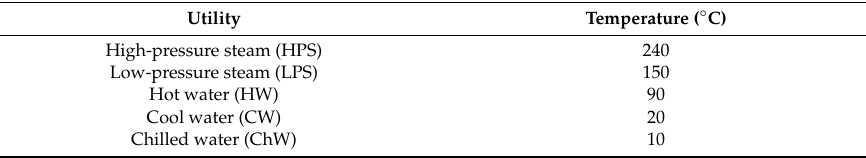
Table 6. Multiple site utility temperatures (modified from Jamaluddin et al. [27]).